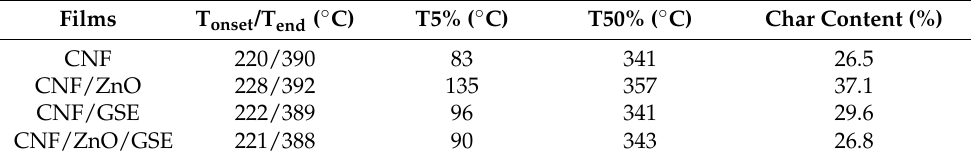
Figure 7. Thermal analysis of CNF/ZnO/GSE films: ( a ) TGA, ( b ) DTG plots, and ( c ) differential scanning calorimetry (DSC). Table 2. Thermogravimetric analysis data of CNF/ZnO/GSE nanocomposite films.